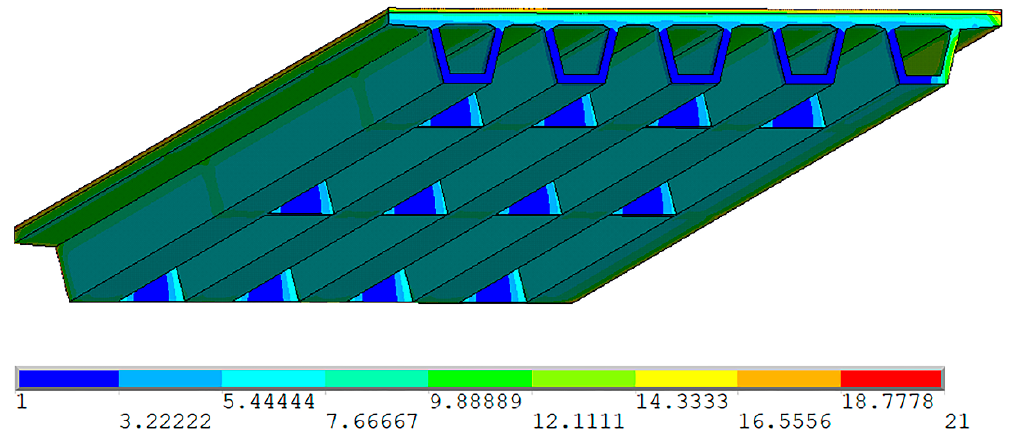
Figure 11. Simulated temperature distribution in the box girder at 15:00 on 31 December 2019 (unit: °C).